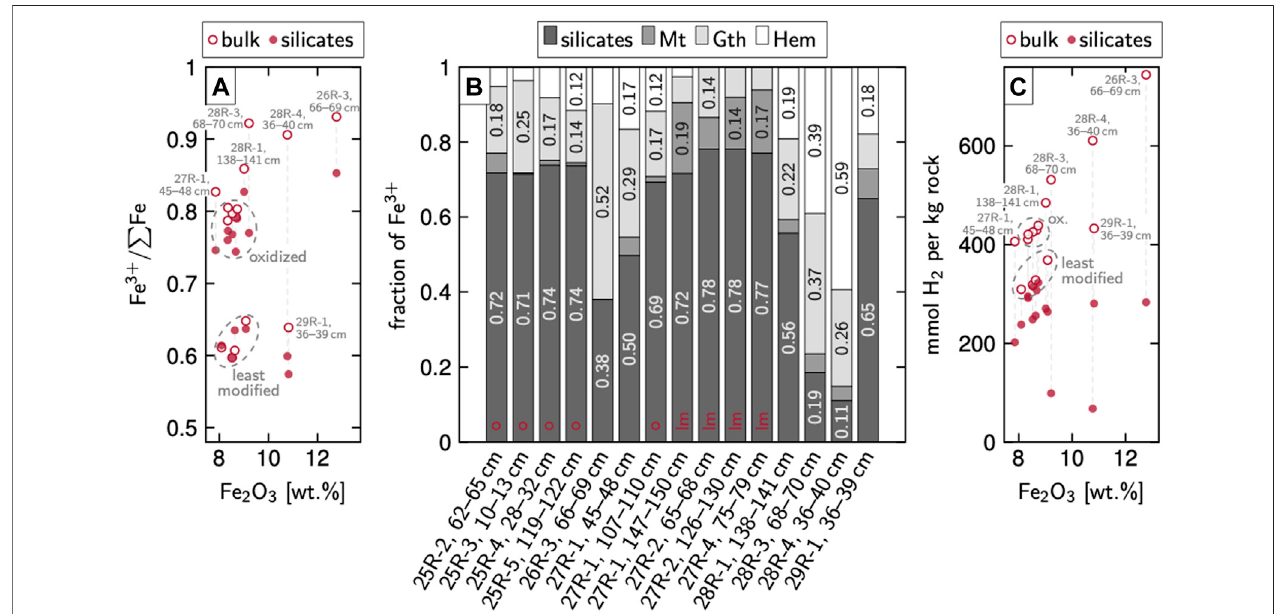
FIGURE 7 | Contents and distribution of Fe(III) in Hole 637A serpentinites and inferred H 2 production (A) Total Fe 2 O 3 from bulk geochemistry vs. Fe(III)/ (cid:1) Fe of bulk rock and silicates from Mössbauer spectroscopy. Most of the ferric Fe in silicates is likely hosted by serpentine. Dashed lines connect values of individual samples (B) Distribution of Fe(III) within the individual samples. In most samples, silicates comprise about 70% whereas magnetite hosts only minor amounts of ferric Fe. Labels ‘ o ’ and ‘ lm ’ refer to oxidized and least modi fi ed, respectively (C) Total Fe 2 O 3 vs. amounts of H 2 produced during the oxidation of the samples, as calculated on the assumption that all Fe has initially been ferrous and was oxidized by H 2 O during the fl uid – rock interactions. Abbreviations: G th, goethite; Hem, hematite; Mt, magnetite.